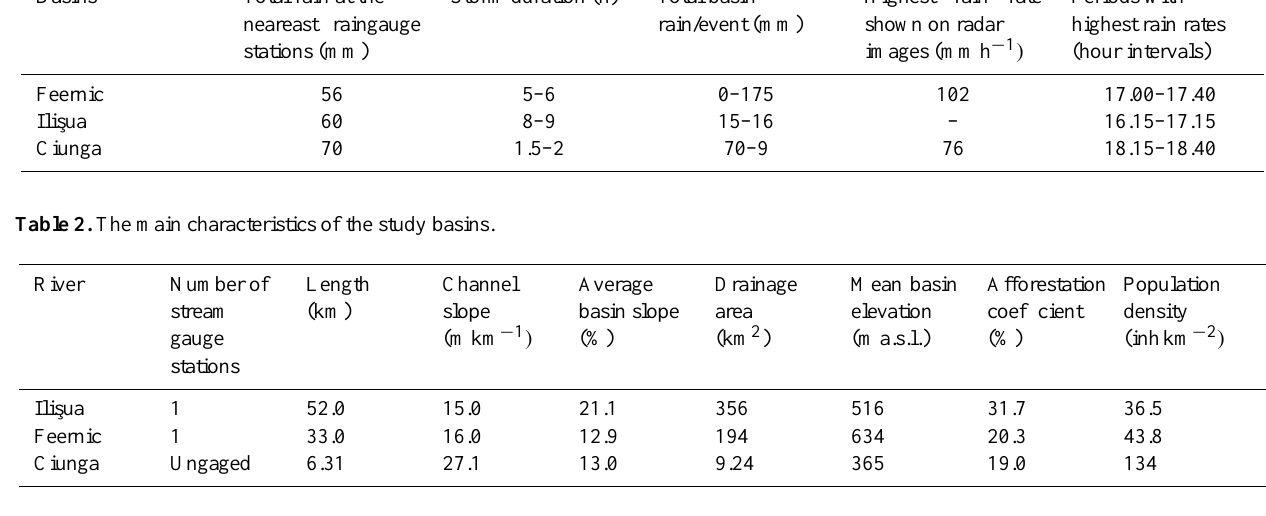
Table 1. Rainfall characteristics for the surveyed basins. Basins Total rain at the